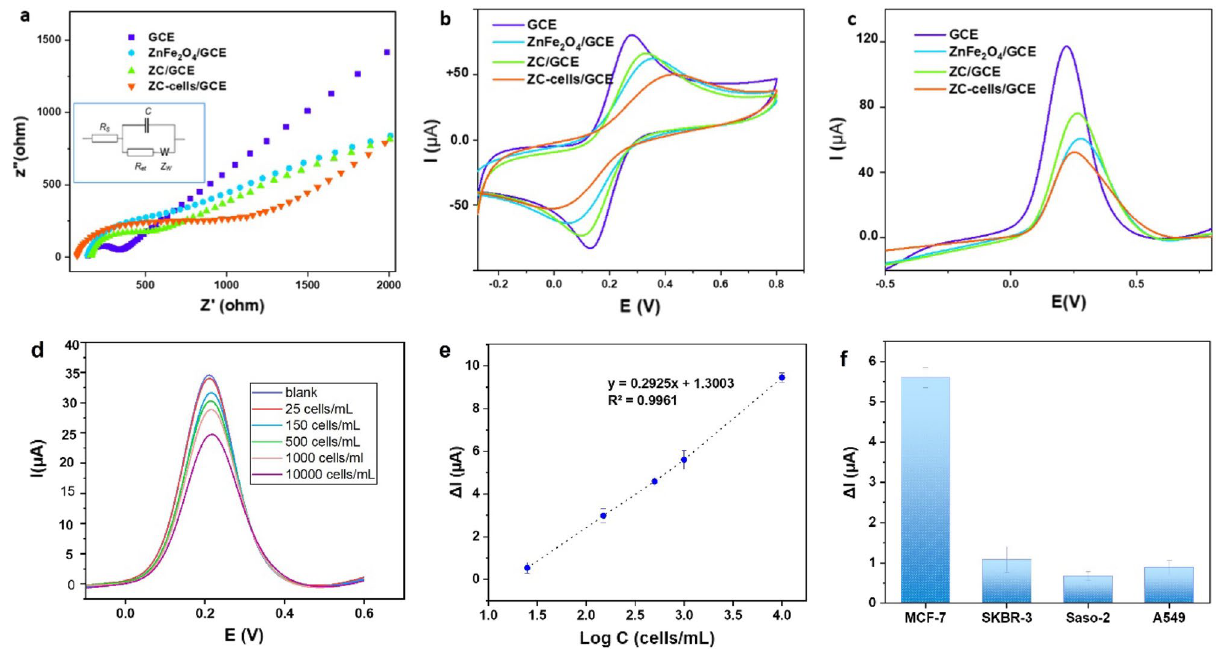
Figure 6. ( a ) EIS, ( b ) CV and ( c ) SWV responses of the bare GCE, ZnFe 2 O 4 /GCE, ZC/GCE, and ZC-cells/GCE, ( d ) DPV response of different concentrations of MCF-7, ( e ) regression analysis of ΔI toward the logarithmic concentration of MCF-7 cells (ΔI represents the current decrease of the blank versus different concentrations of MCF-7 cells, ( f ) the selectivity of the cytosensor, (inset a) the schematic display of Randle’s equivalent circuit (error bars represent the standard deviations, n =